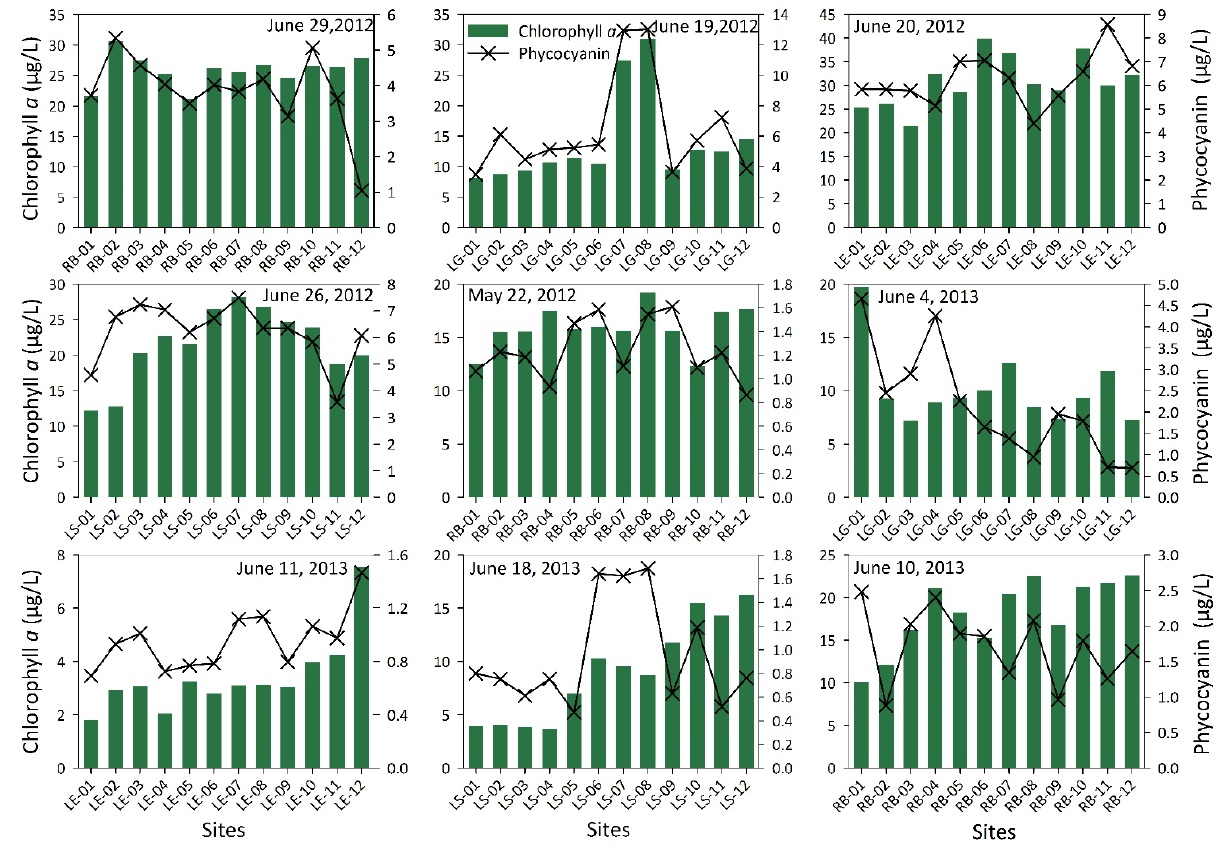
Figure 5. Chlorophyll a concentrations shown with cyanobacterial unique pigment phycocyanin concentrations at twelve sampling sites in each of the lakes (RB = Ross Barnett Reservoir, LG = Lake Grenada, LE = Lake Enid, and LS = Lake Sardis) with sampling dates